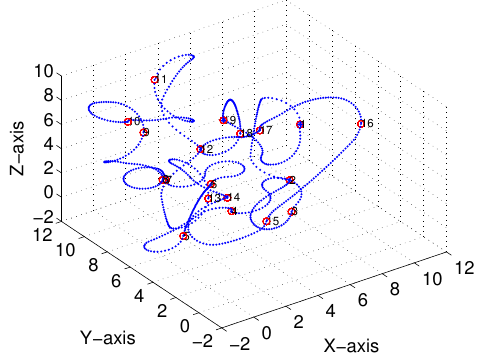
Figure 12. Linear-interpolation-based three-dimensional (3D) Dubins curves (case 1).